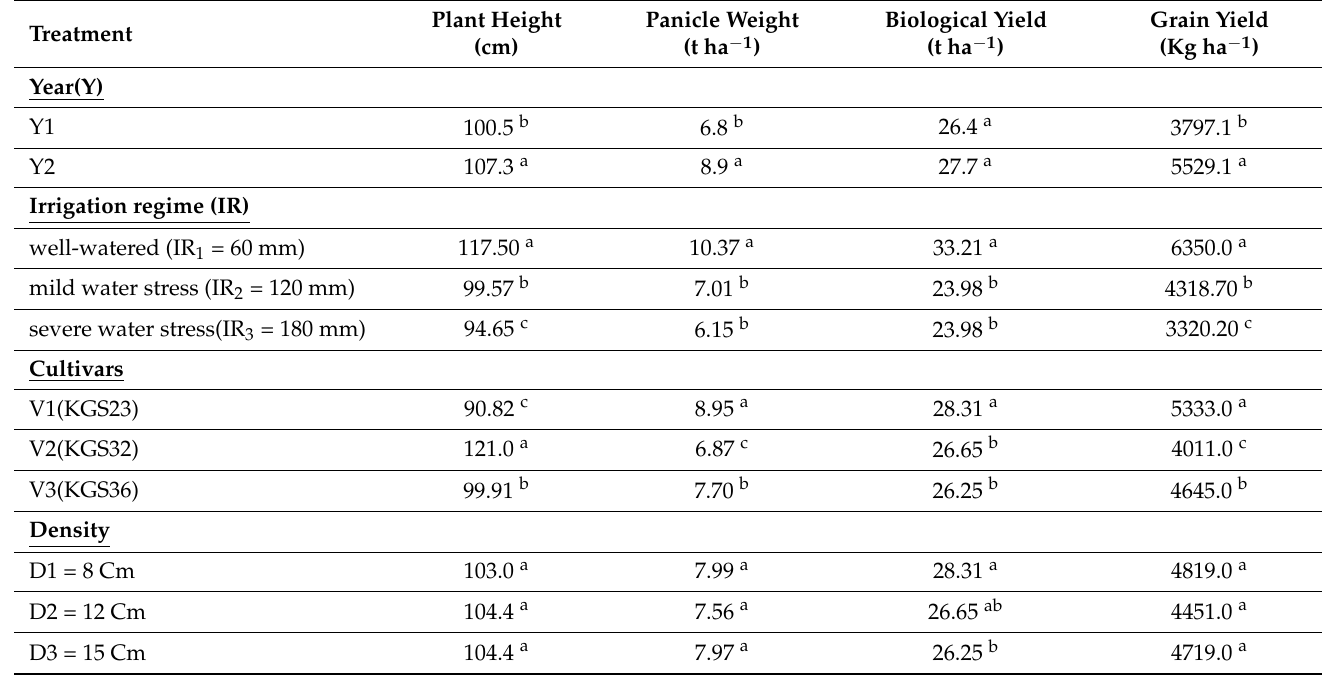
Table 1. Mean of comparison some of morphological characteristics, biological yield and grain yield in promising grain sorghum lines.